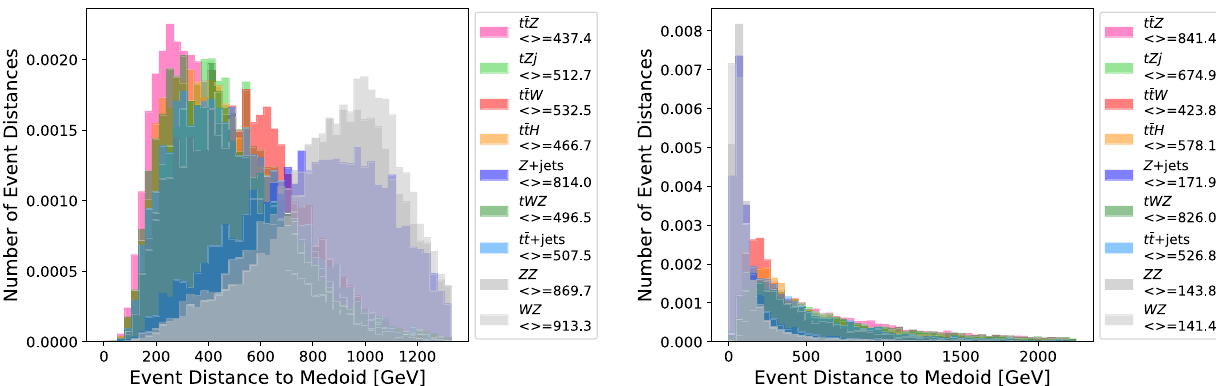
Fig. 3 Distribution of the event distances d ( I , J ) to the (left) 2nd t ¯ tZ medoid and to the (right) 1st W Z medoid for each process sample. All distributions are normalized to the unit area